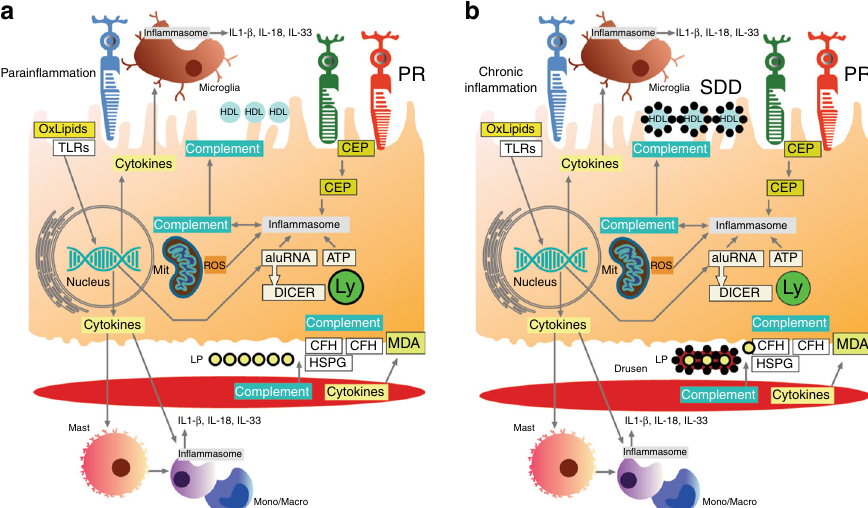
Fig. 4 Cartoon of in fl ammatory processes involved in AMD pathobiology. In the subretinal space, oxidized lipids and excess HDLs can elicit an in fl ammatory response that includes microglial and systemic monocyte recruitment. a Initially, immune responses are heightened, representing parain fl ammation to maintain cell health. This includes activation of RPE, microglia, and potentially choroidal macrophages, with heightened intracellular cytokine responses (IL-18, IL-33), upregulation of autophagy, and immunometabolic regulation to maintain mitochondrial health. b Conversion from parain fl ammation to chronic in fl ammation can induce in fl ammasome activation by microglia, monocytes and the RPE (including IL-1b production) that contributes to subretinal drusenoid deposit formation. In the RPE, complement and the in fl ammasome can be activated by a number of triggers. In Bruch ’ s membrane, the accumulation of lipoproteins and cellular debris elicits an in fl ammatory response from the RPE, mast cells, and monocytes/macrophages derived from the choroid or systemic circulation to activate both complement and the in fl ammasome. In fl ammatory debris accumulates around lipoproteins/HAP particles during drusen formation in Bruch ’ s membrane. CEP carboxyethyllysine, CFH complement factor H, HSPG heparan sulfate proteoglycan, Ly lysosome, MDA malondialdehyde, Mit mitochondria, mono/macro monocyte/macrophage, PR photoreceptor, ROS reactive oxygen species, SDD subretinal drusenoid deposit, TLR Toll-like